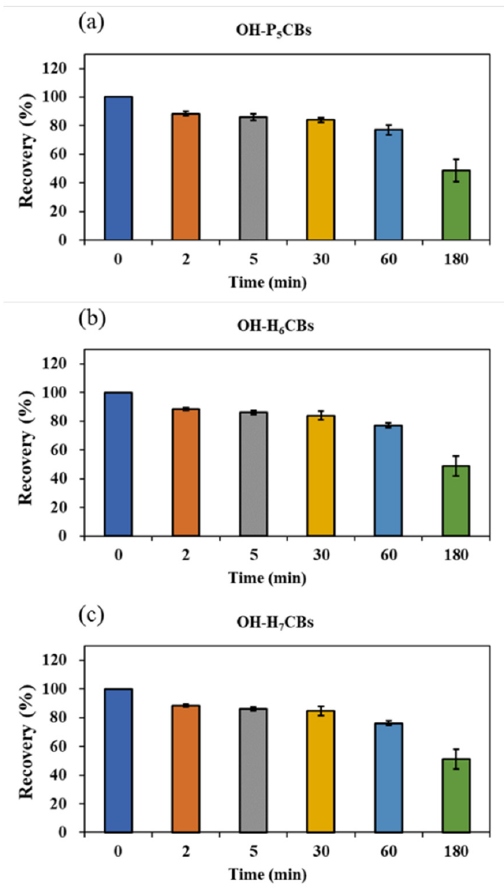
Figure 4. Mean recoveries of penta- ( a ), hexa- ( b ), and hepta-chlorinated ( c ) OH-PCBs treated with H 2 SO 4 at different time points. Rectangles indicate the average recovery of the OH-PCBs containing the same chlorine atoms, which is calculated by the individual OH-PCB peak area under the specific time point with H 2 SO 4 treatment dividing the peak area without H 2 SO 4 treatment. Each test has three replicates. Short bars indicate standard deviations.